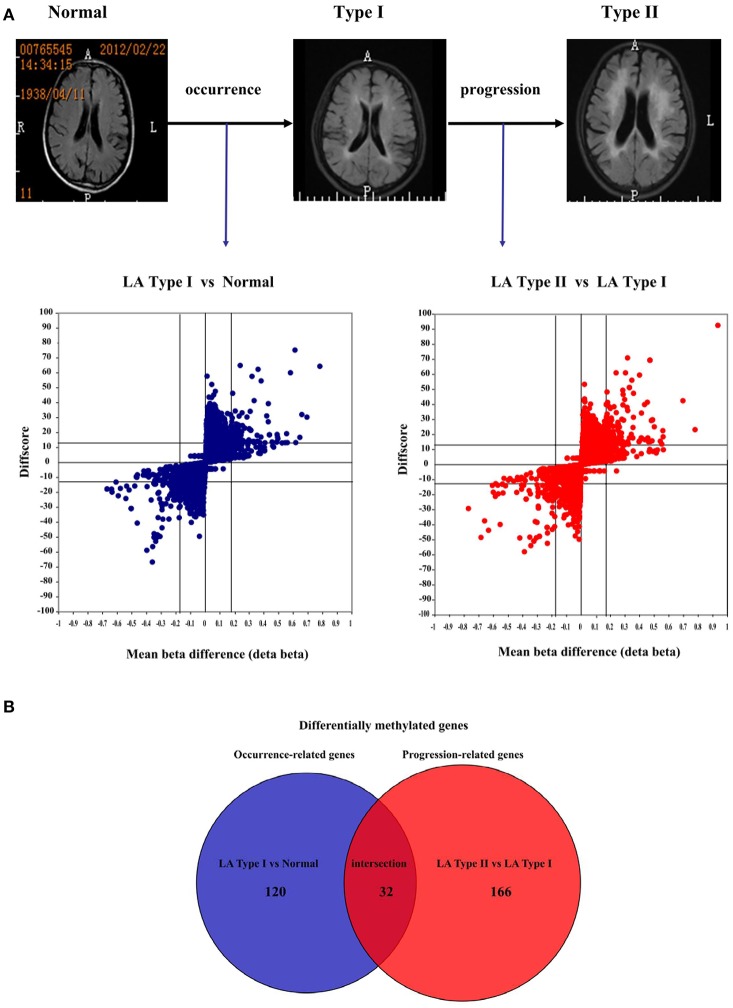
Differential DNA methylation profiles between LA occurrence and progression. (A) Putative physiological processes of human brain imaging showing LA occurrence and progression and volcano plots showing statistically significant DNA methylation difference in LA type I vs. Normal and LA type II vs. LA type I. Those significant CpG sites identified in LA type I (vs. Normal) and LA type II (vs. LA type I) are considered to be the LA occurrence-associated sites and LA progression-associated sites, respectively. The X axis represents the mean beta difference (Δβ) which indicates the relative methylation change within groups. The Y axis represents absolute DiffScore value for each significant CpG sites from the two sided t-test. The differential methylation cutoff is |Δβ|≥ 0.17 and |DiffScore|>13.The blue/red dot represents the significant CpG sites identified from the comparison of LA type I with Normal and the comparison of LA type II with LA type I, respectively. (B) Venn diagram showing highly significant overlapping between differentially methylated genes identified in LA occurrence and those in progression. The number in the blue circle represents the number of differentially methylated genes associated with LA occurrence in the comparison (LA type I vs. Normal). The number in the red circle represents the number of differentially methylated genes associated with LA progression in the comparison (LA type II vs. LA type I). The number of the crimson circle represents the number of overlapping genes across these different comparisons.